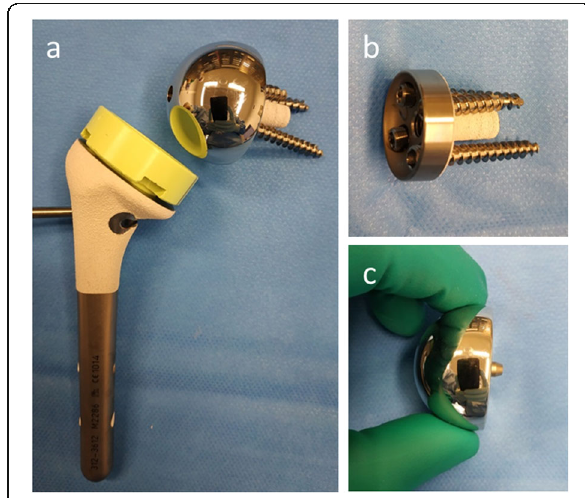
Fig. 1 Photograph of a reverse shoulder arthroplasty before implantation in the operating room. a Complete prosthesis.